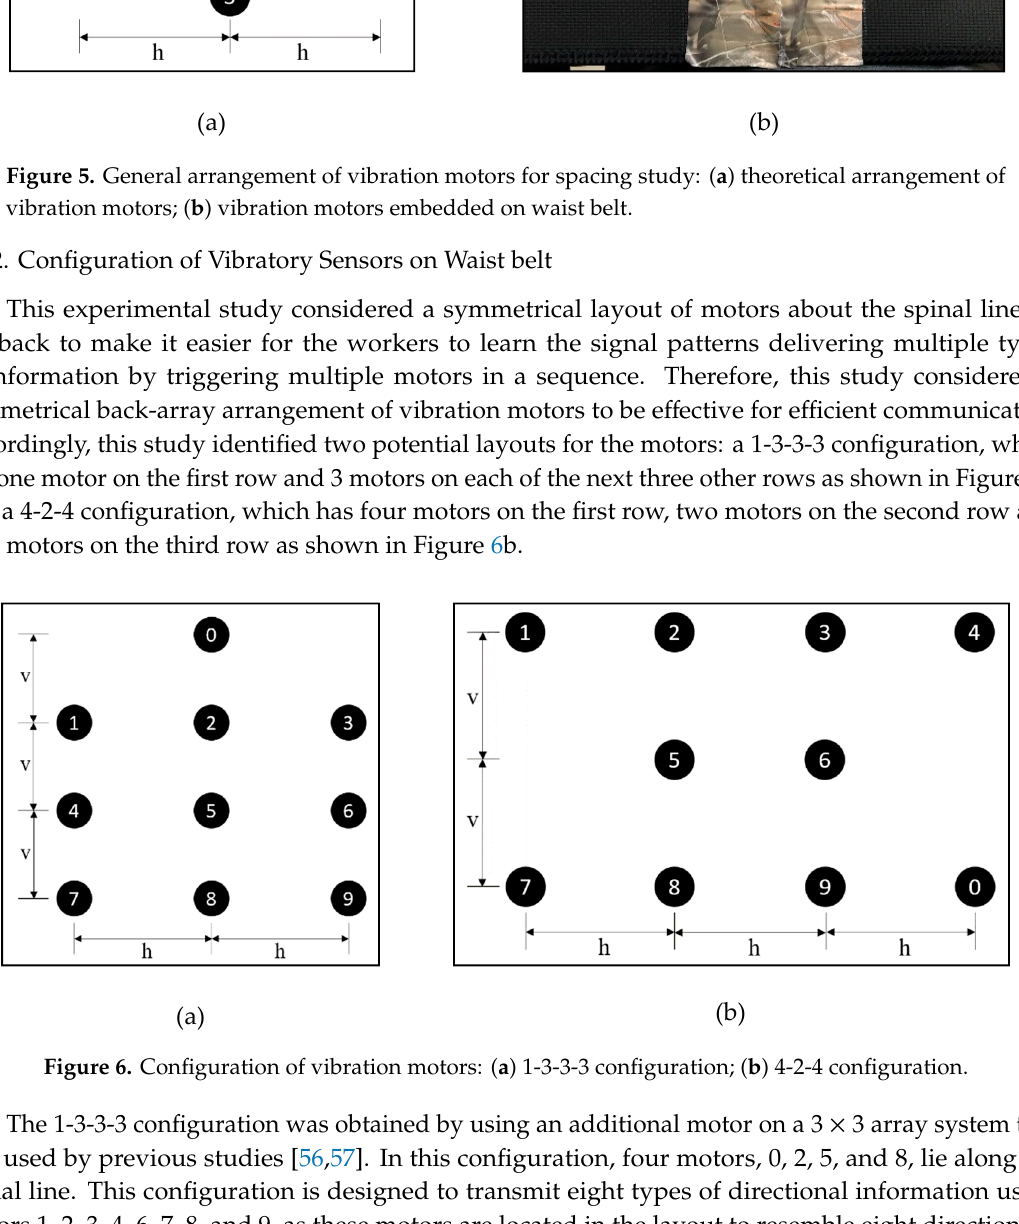
Figure 6. Configuration of vibration motors: ( a ) 1-3-3-3 configuration; ( b ) 4-2-4 configuration.